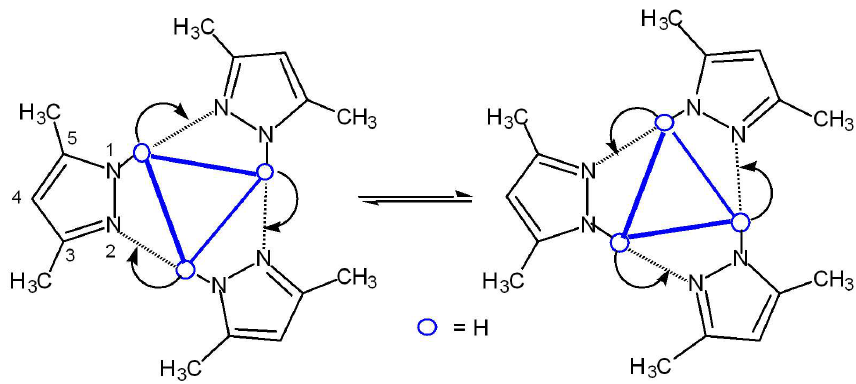
Fig. 1 The clockwise/anti-clockwise concerted jump of the three NH protons in 1